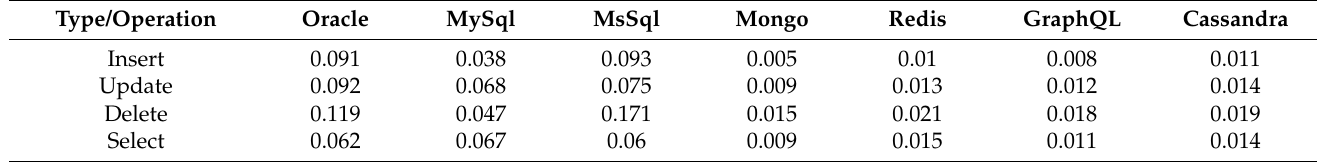
Table 4. Query performance of databases with 100,000 records in